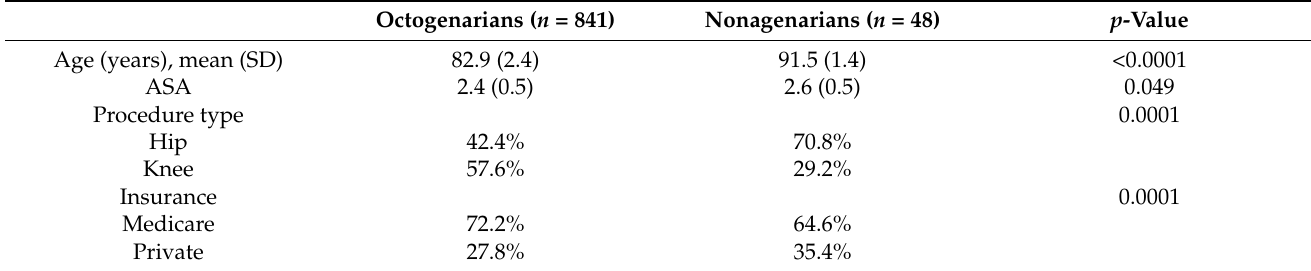
Table 1. Comparison of patient characteristics for octogenarians and nonagenarians undergoing primary total hip or knee arthroplasty. ASA = American Society of Anesthesiologists classification.